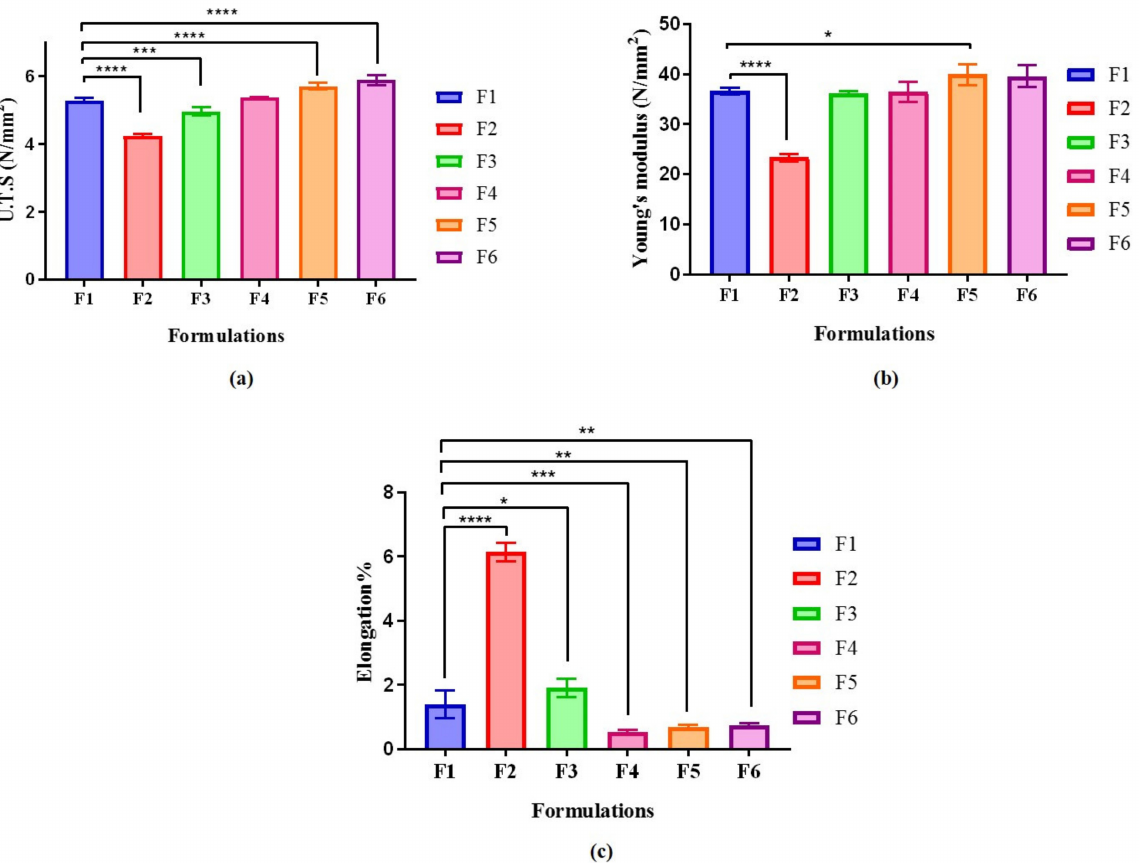
Figure 2. Mechanical properties of dried films of p(HEMA) and drugs-loaded p(HEMA) detected by Texture Analyzer. ( a ) U.T.S. N/mm 2 , ( b ) Young’s modulus (N/mm 2 ) and ( c ) Elongation%.: Values shown presenting average mean ± SD, n = 3. * p < 0.05, ** p < 0.01, *** p < 0.001, and **** p < 0.0001, a significant difference between formulations. The Young’s modulus of p(HEMA) (control, F1) was 36.60 ± 0.61 N/mm 2 . AMP- loaded p(HEMA) significantly lowered the Young’s modulus to 23.39 ± 0.75 N/mm